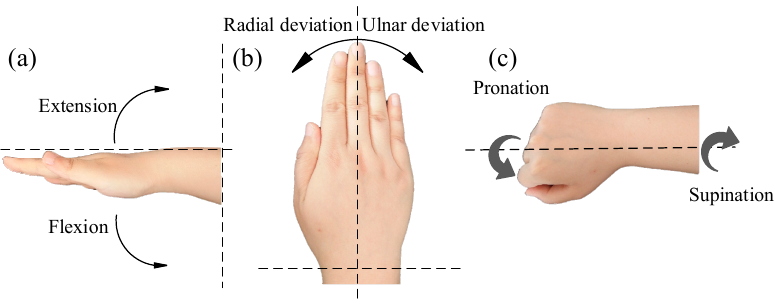
Figure 1. ( a ) Flexion/Extension (F/E); ( b ) Radial/Ulnar deviations (R/U); ( c ) Pronation/Supination (P/S).